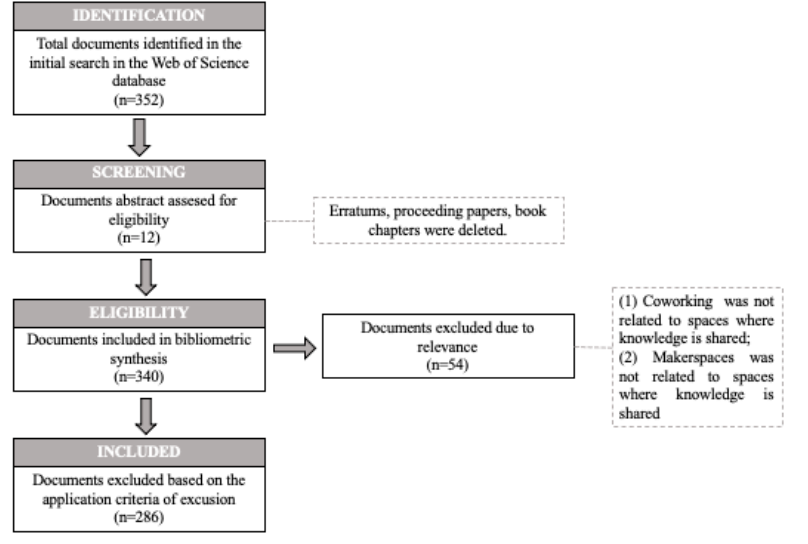
Figure 1. PRISMA flow diagram.